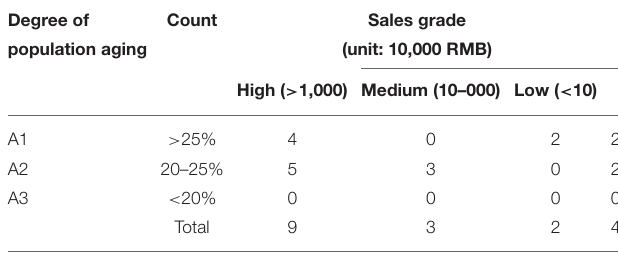
TABLE 6 | Analysis of average sleep hours daily and sales of smart beds.